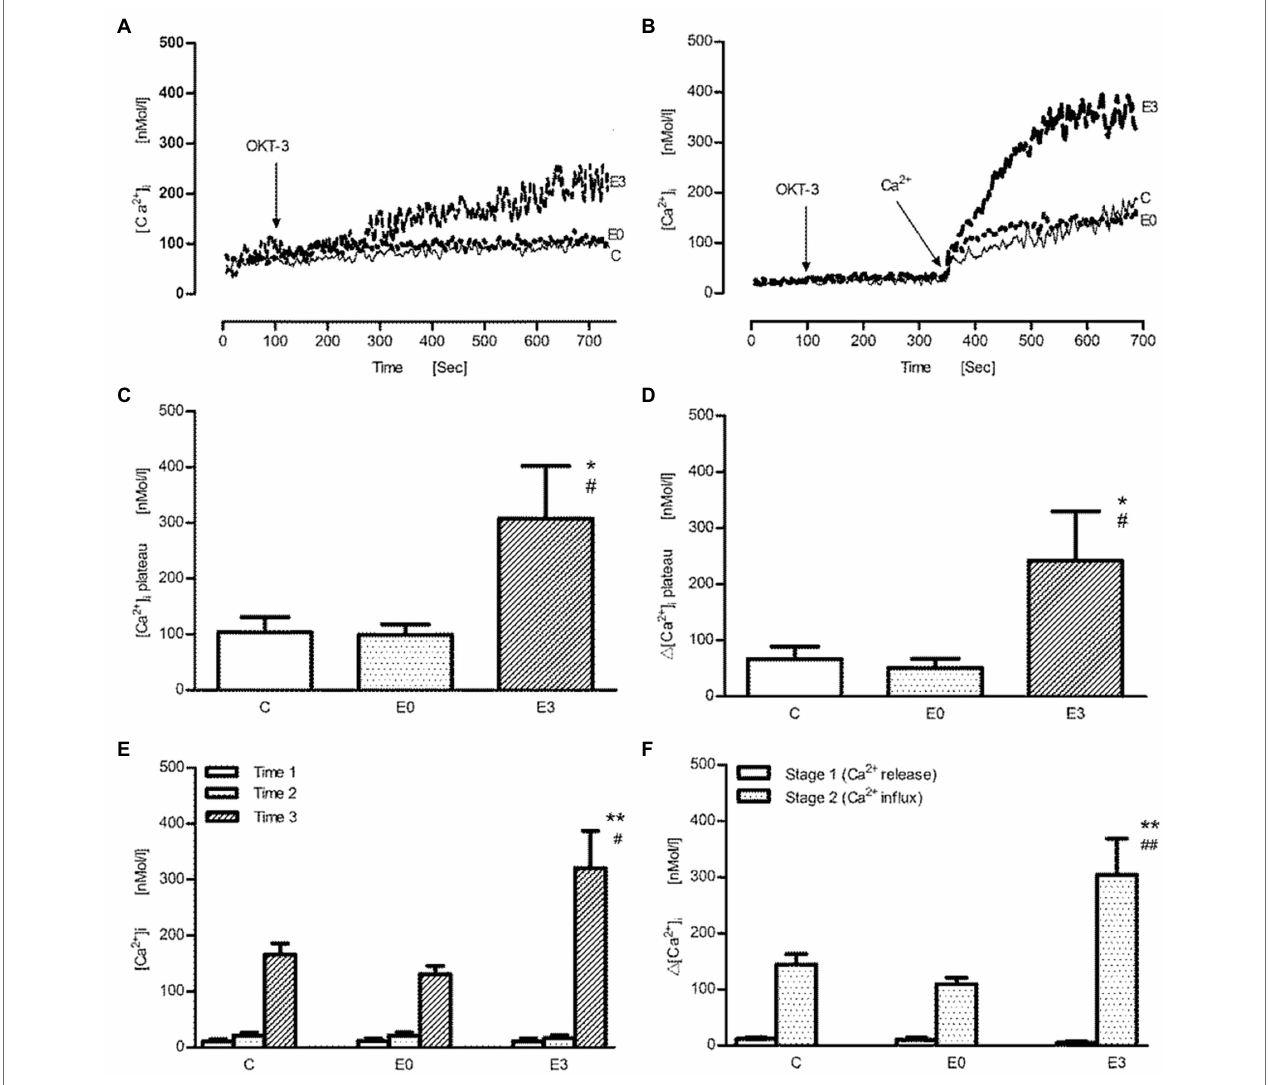
FIGURE 3 | The effect of acute exercise on OKT3-induced change of [Ca 2+ ] i of murine splenic lymphocytes at the different time points after exercise. (A,B) The representative tracings of OKT3-induced change of intracellular Ca 2+ signal in the calcium buffer and the Ca 2+ -free buffer, respectively; arrow shows when OKT3 (at 100 s) and Ca 2+ were applied (at 350 s); tracing C, the control group; tracing E0, and E3 indicate the exercise groups with cell isolation at time points after and 3 h after exercise. (C–F) Bar chart diagrams summarize the results of the entire group. (C,D) The measurement was performed in the Ca 2+ buffer; [Ca 2+ ] i plateau and Δ [Ca 2+ ] i plateau were referred to as absolute [Ca 2+ ] i and net [Ca 2+ ] i during the plateau phase after stimulation with OKT3, respectively. (E,F) The measurement was performed in the Ca 2+ -free buffer; after the initiative scanning for time 1, OKT3 was added into the buffer for time 2. Next, calcium was administrated for time 3; the calculated Δ [Ca 2+ ] i levels of stage 1 and stage 2 indicate Ca 2+ release from ER and transmembrane Ca 2+ influx from extracellular space, respectively. Data are presented as means ± SEM ( n = 5). * p < 0.05 or ** p < 0.01 vs. control, # p < 0.05 or ## p < 0.01 vs. E0 ( n =